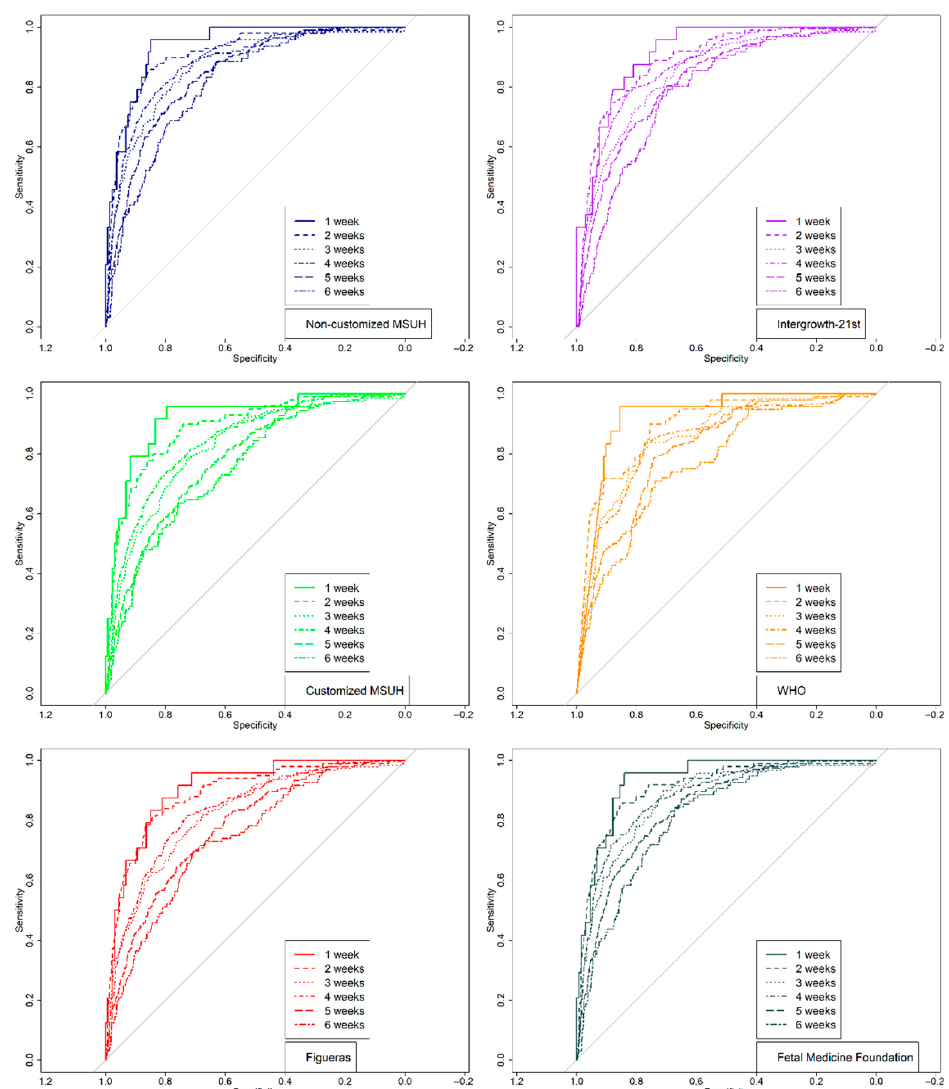
Figure 7. Receiver operating characteristic curves: comparison of fetal growth standards and area under the curve for prediction of small for gestational age (SGA) by standard and by ultrasound–delivery interval (1–6 weeks). Growth standards: non-customized Miguel Servet University Hospital (MSUH), customized MSUH, Figueras et al., INTERGROWTH-21st, World Health Organization (WHO), and Fetal Medicine Foundation.